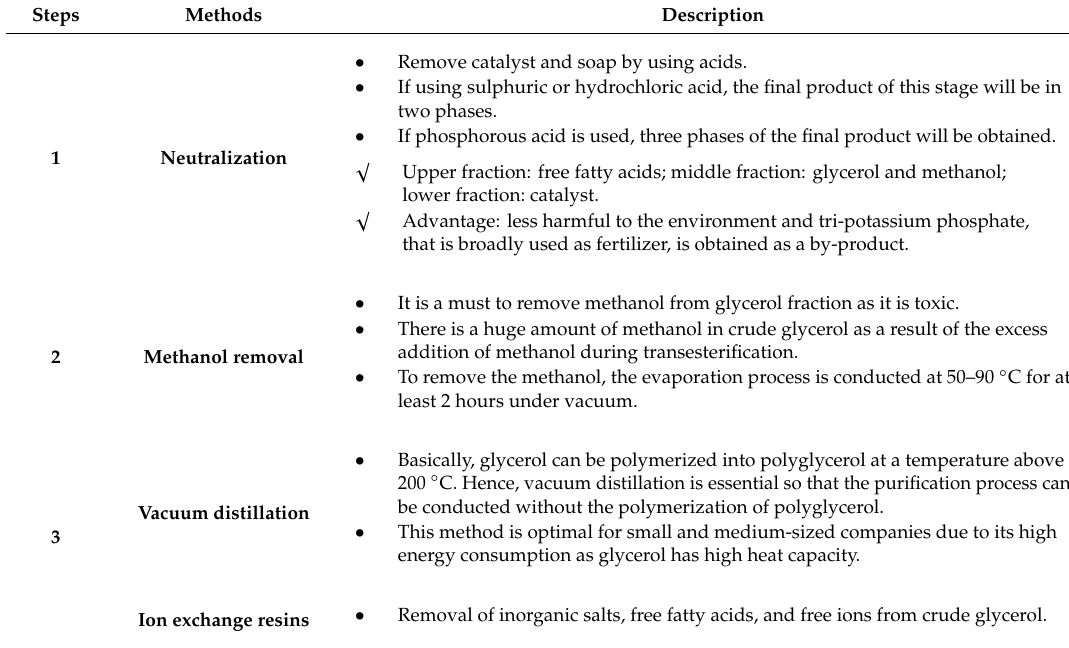
Table 1. Typical steps in crude glycerol purification